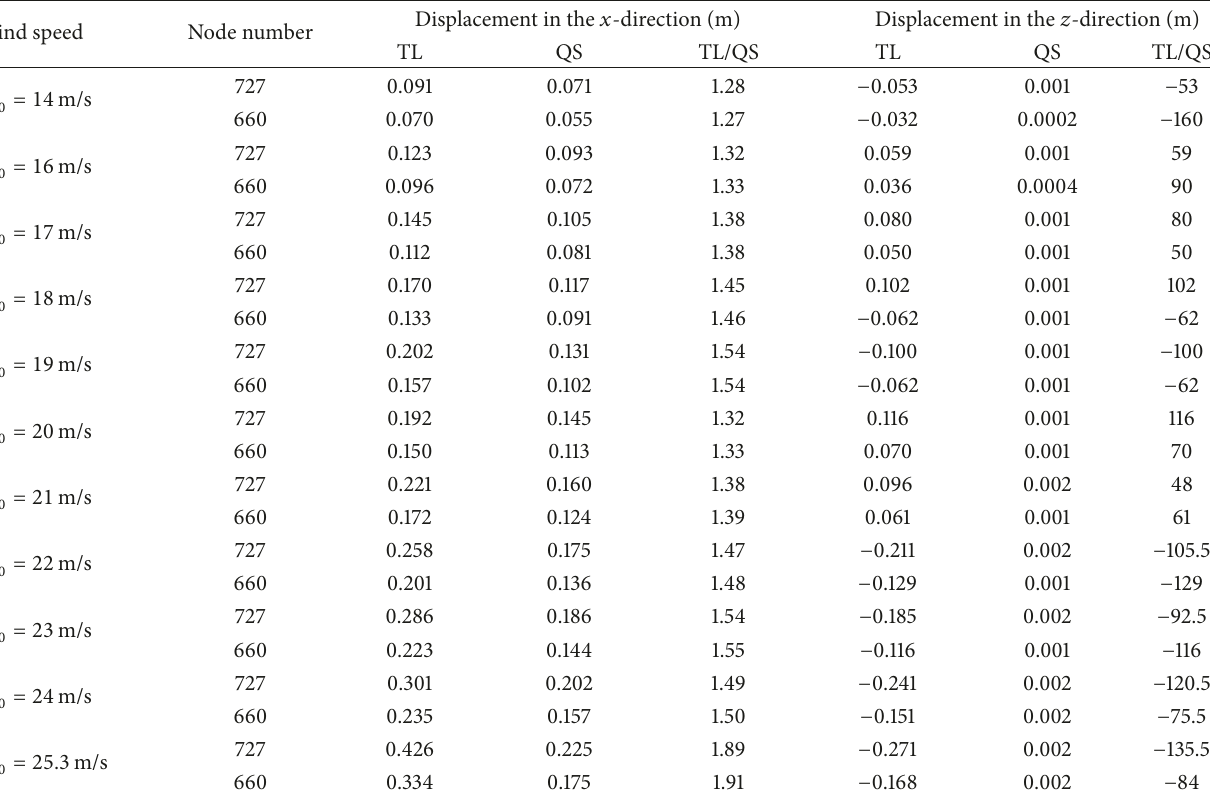
Table 11: Comparison of the displacements of the tower calculated by dynamic analysis in the tower-line system and the displacement given by the quasi-static calculations for the corresponding single